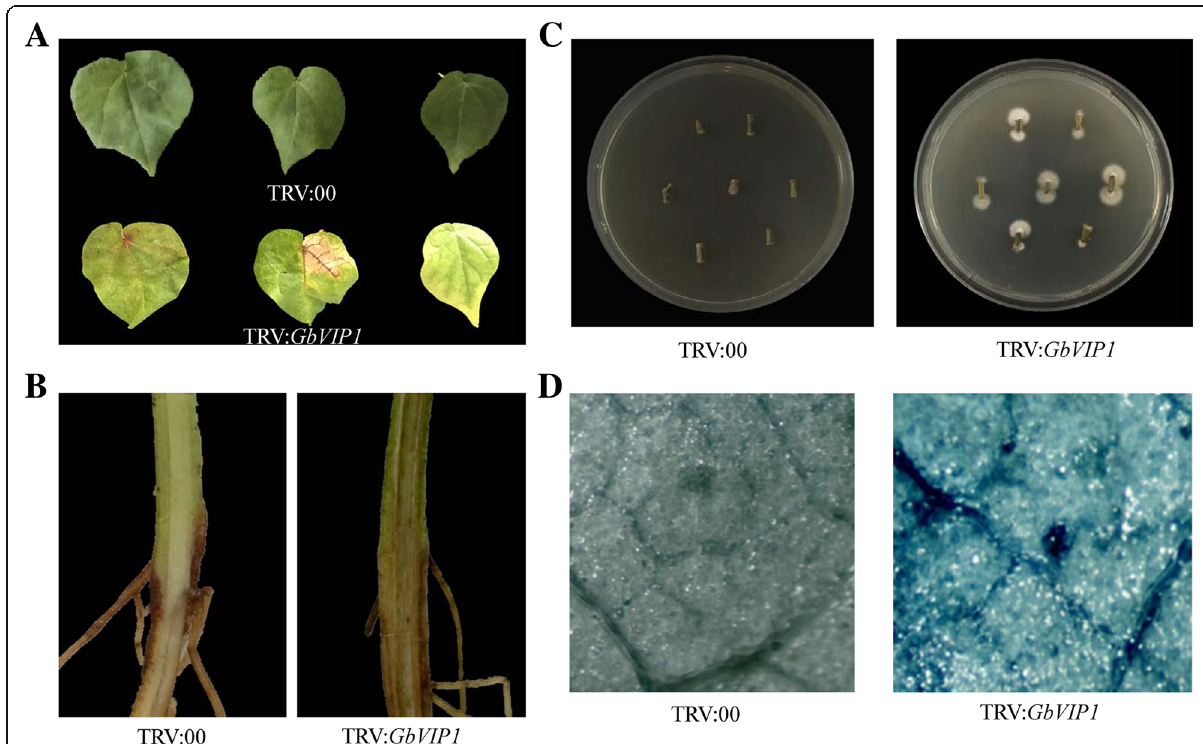
Fig. 4 Leaf and stem sections from GbVIP1 silenced and control cotton seedlings. a Detached leaves from GbVIP1 silenced and control cotton seedlings after V. dahliae infection. b Stem sections from GbVIP1 silenced and control cotton seedlings after V. dahliae infection. c Recovery experiments of stem sections from GbVIP1 silenced and control cotton seedlings after infection of V. dahliae infection. d Trypan blue dye experiments of leaves from silenced and control cotton seedlings after infection of V. dahliae